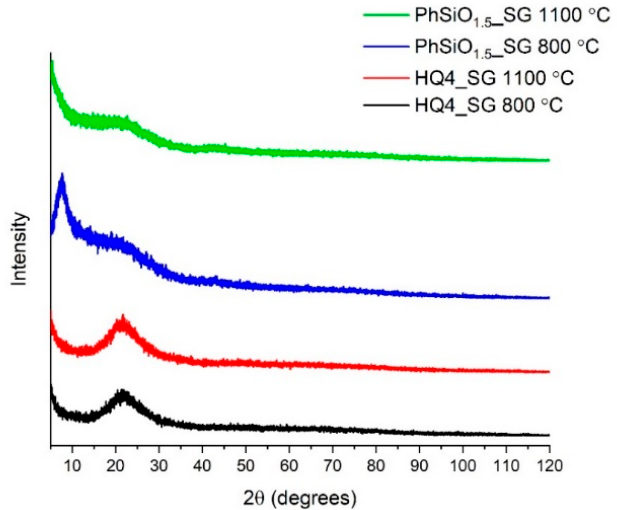
Figure 2. XRD patterns of PhSiO 1.5 _SG and HQ4_SG pyrolyzed to 800 °C and 1100 °C.